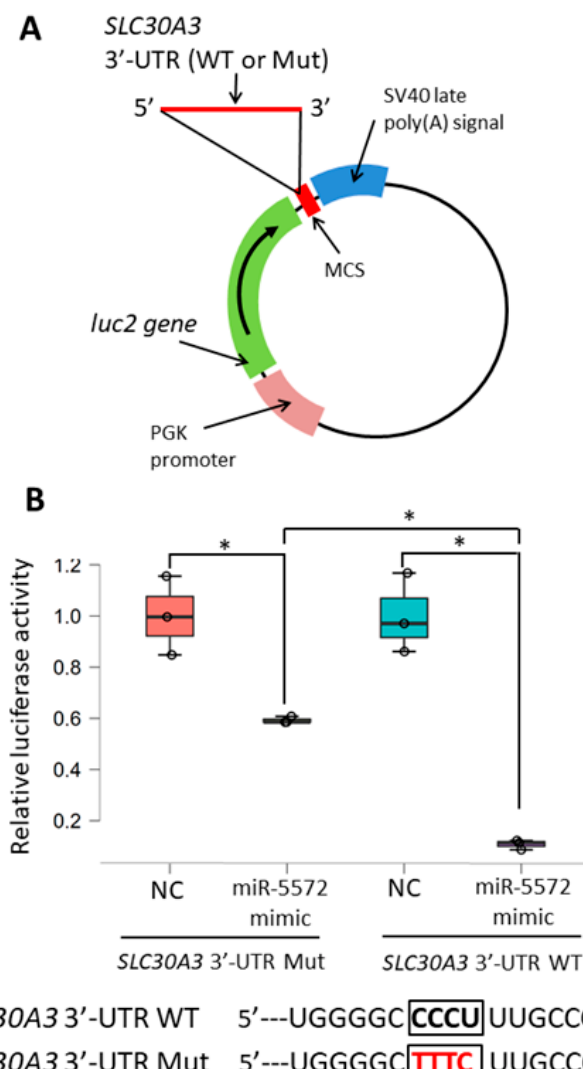
Figure 4. Reporter gene assay for the functional analysis of 3 ′ -UTR regulated by miRNA. ( A ) The reporter construct contained the inserted DNA fragment of human SLC30A3 3 ′ -UTR wild type (WT) or mutant (Mut) downstream of luc2 in the pmirGLO Dual-Luciferase miRNA Target Expression Vector. ( B ) Reporter gene assay was performed using CHO cells co-transfected with NC or miR-5572 mimic, and the reporter vector cloned with WT 3 ′ -UTR of SLC30A3 or mutant 3 ′ -UTR of SLC30A3 ( n = 3 in each experimental group). All data are presented as box and scatter plot. Statistical significance was determined by two-way ANOVA followed by post hoc Bonferroni’s test (* p < 0.05).